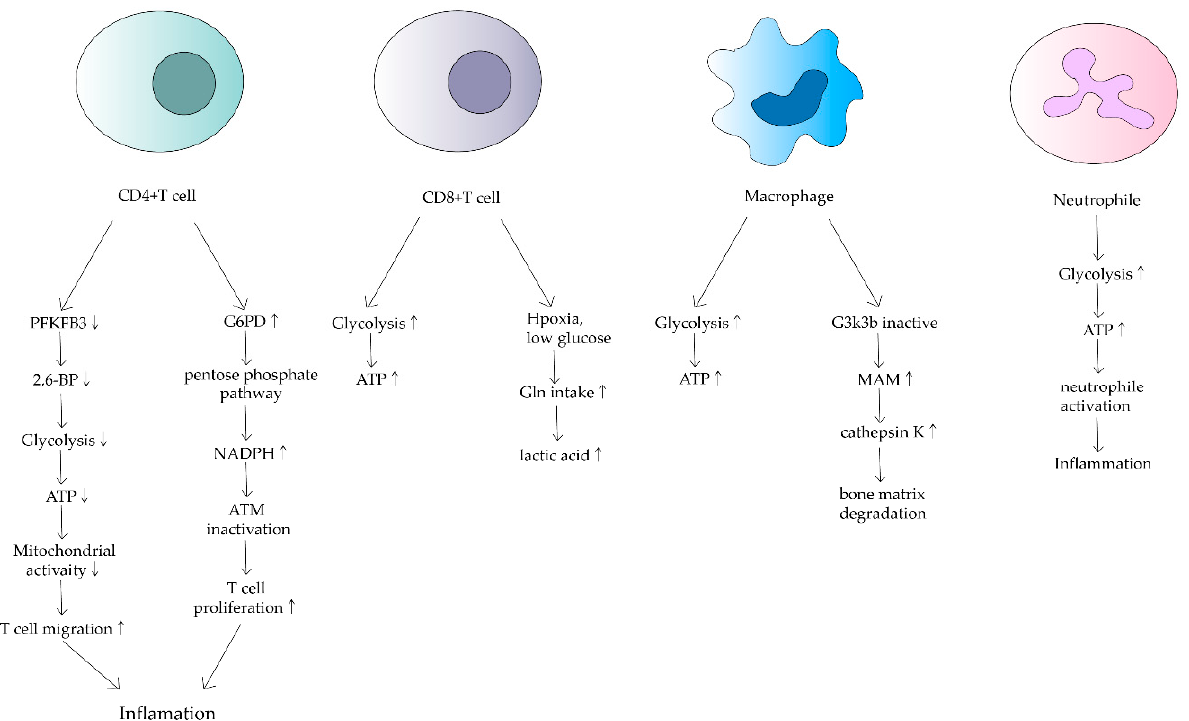
Figure 2. Effects of mitochondrial dysfunction on different immune cells in RA. This shows that ATP synthesis increases in CD4+ T cells, macrophages and neutrophils. In contrast, it decreases in CD8+ T cells. Different cells have different mechanisms that lead to inflammation and bone matrix degradation, causing the development of RA.